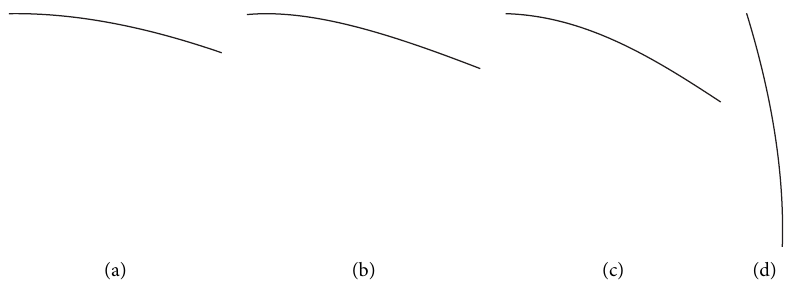
Figure 9: Displacement deformation diagrams. (a) k � 5/6 (b) k � 2/3 (c) k � 1/3 (d) k � 0.